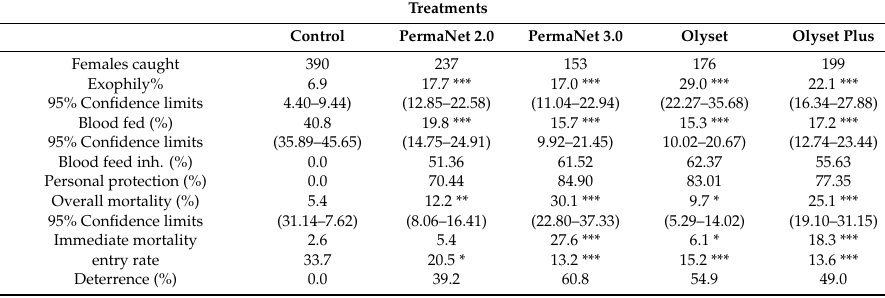
Figure 2. Performance of the four LLINs in experimental hut trials against pyrethroid resistant An. funestus in Cameroon. ( A ) Mosquito species composition during the experimental hut study. ( B ) Proportion of mortality and blood feeding rate for the four LLINs against An. funestus. Table 2. Results of the performance of the five brands of LLINs against wild An. funestus females in experimental huts.